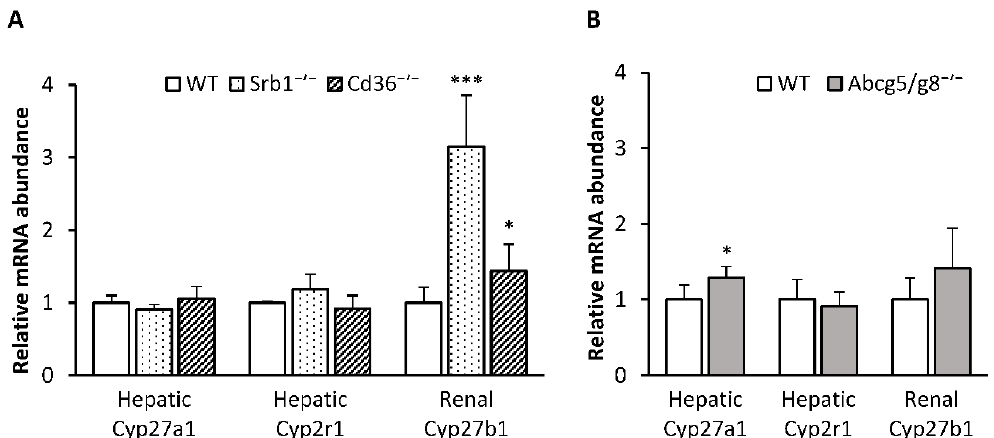
Figure 3. Relative mRNA abundance of hydroxylases in the liver and kidney of Srb1 - / - and Cd36 - / - mice versus corresponding wild-type (WT) mice ( A ), and Abcg5 / g8 - / - mice versus corresponding WT mice ( B ). All mice were fed diets containing 25 µ g / kg triple-deuterated vitamin D 3 (vitamin D 3 -d 3 ) for six weeks. Data are presented as the means ± SD, n = 5–7; *** p < 0.001, * p < 0.05 (compared to the corresponding WT mice, Student’s t test). Abcg5 / g8 - / - , ATP-binding cassette transporters G5 / G8 knockout mice; Cd36 - / - , cluster determinant 36 knockout mice; Cyp27a1, sterol 27-hydroxylase; Cyp27b1, 25-hydroxyvitamin D 1 α -hydroxylase; Cyp2r1, vitamin D 25-hydroxylase; Srb1 - / - , scavenger receptor class B type 1 knockout mice.